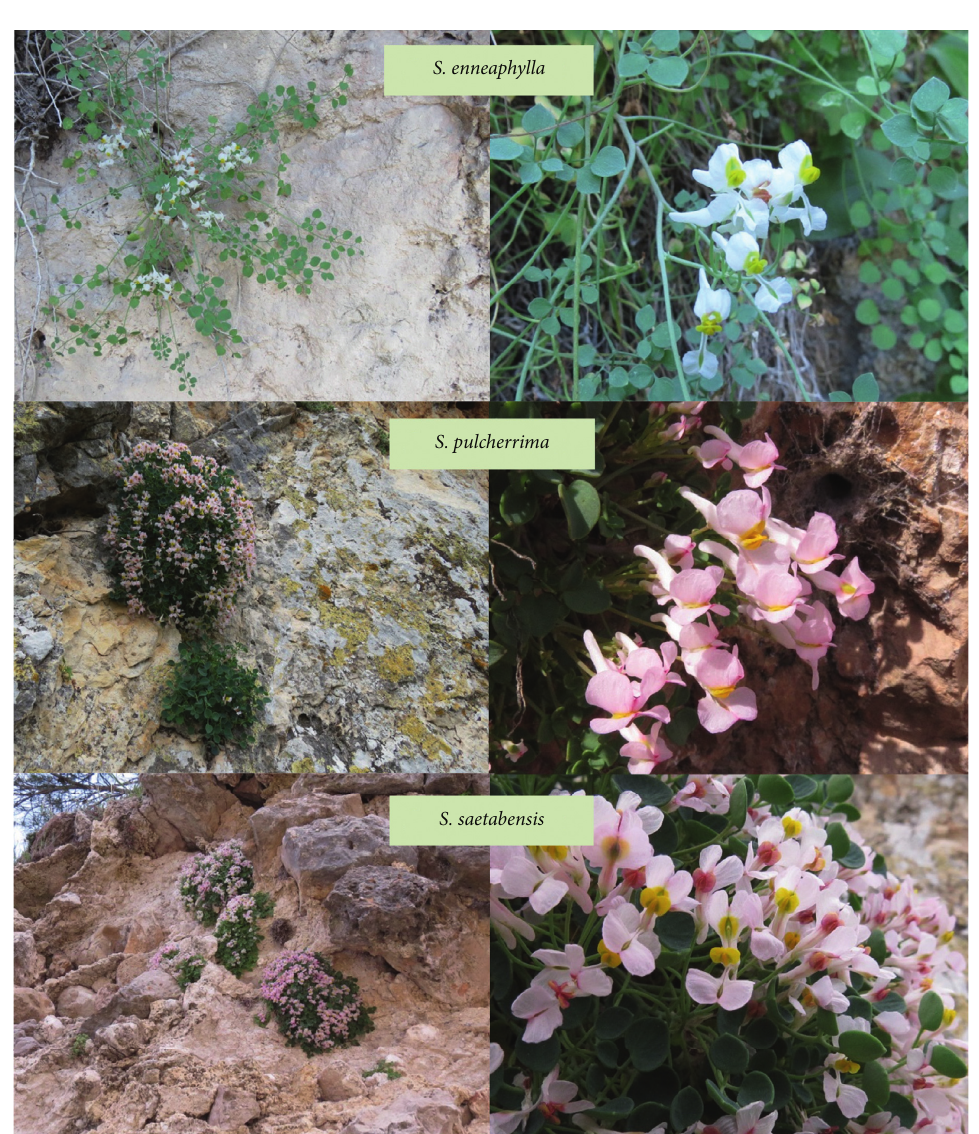
Figure 1: Photographs of S. enneaphylla , S. pulcherrima , and S. saetabensis